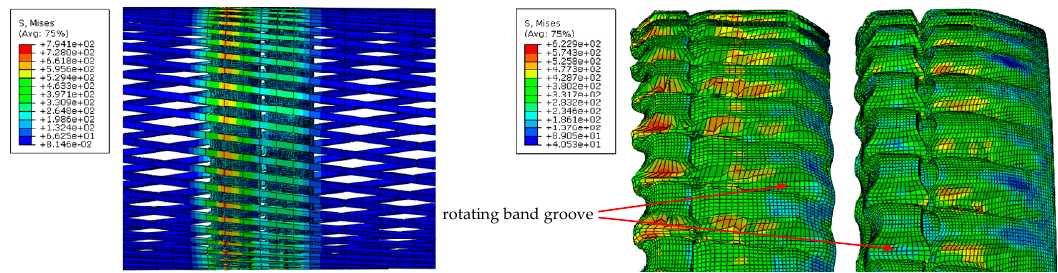
Figure 8. Mises stress and morphology at 6.2 ms in the engraving period.